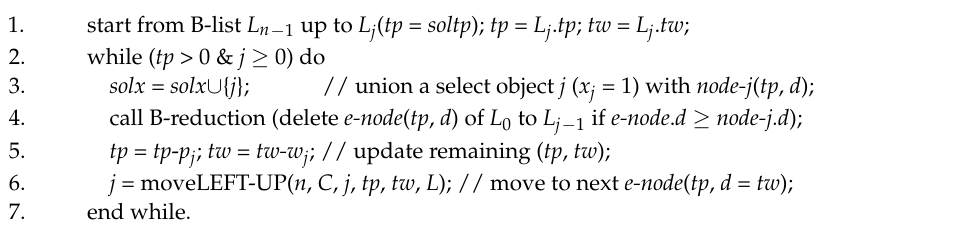
Algorithm 8: X-tracking (for solx ) on B-lists of the DPT-List TSR algorithm.